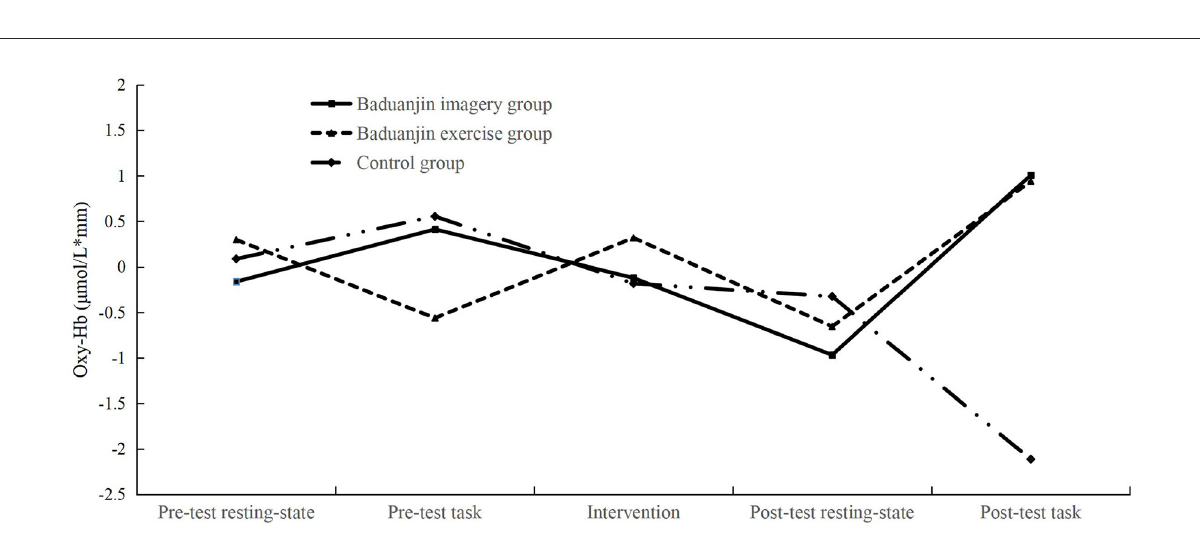
FIGURE5 In the incongruent task, the mean oxy-Hb concentration variations of the right IFG for the three groups of participants ( µ mol/L × mm). After the intervention, the oxy-Hb variations were significantly higher in participants of the Baduanjin imagery group than in the Control